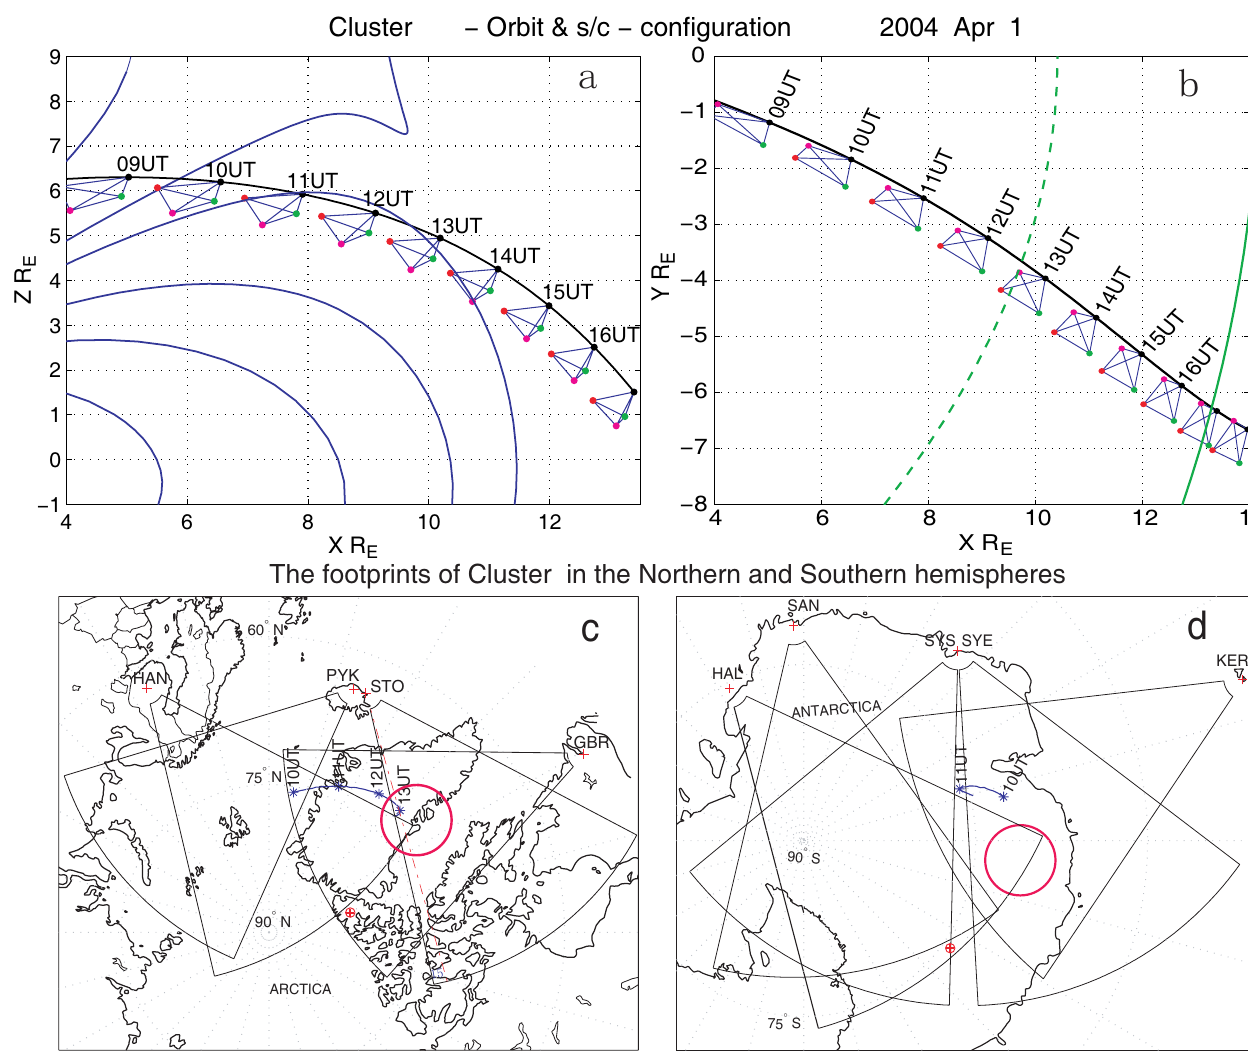
Fig. 1. Cluster spacecraft tracks in the X-Z (a) and X-Y (b) planes in GSM coordinates, together with the ionospheric footprints of Cluster S/C 1 on the maps of Northern (c) and Southern (d) Hemispheres, on 1 April 2004. The orbit also shows the configuration of the Cluster spacecraft array as a tetrahedron (size scaled up by a factor of 20). Model geomagnetic field lines are shown for the projection into the X-Z plane and cuts through the bow shock (BS) and magnetopause (MP) are shown for the X-Y plane. The X-Z plane field lines and ionospheric footprints of the spacecraft are drawn from the Tsyganenko ’96 model with the average inputting parameters: Pdyn=1.35nPa, IMF B Y =0.14nT, IMF B Z = − 2.90nT and D st = − 10nT. The field-of-view of the CUTLASS radars (HAN and PYK), Stokkseyri radar (STO), and Goose Bay radar (GBR) are presented as a fan in Fig. 1c. The field-of-view of the Halley radar (HAL), Sanae radar (SAN), Syowa South radar (SYS), Syowa East radar (SYE), and Kerguelen radar (KER) are presented as fans in Fig. 1d. The red “ ⊕ ” in Fig. 1c and d represents the geomagnetic north and south pole, respectively. The red circle represents location of the flow region we will examine in Sect.